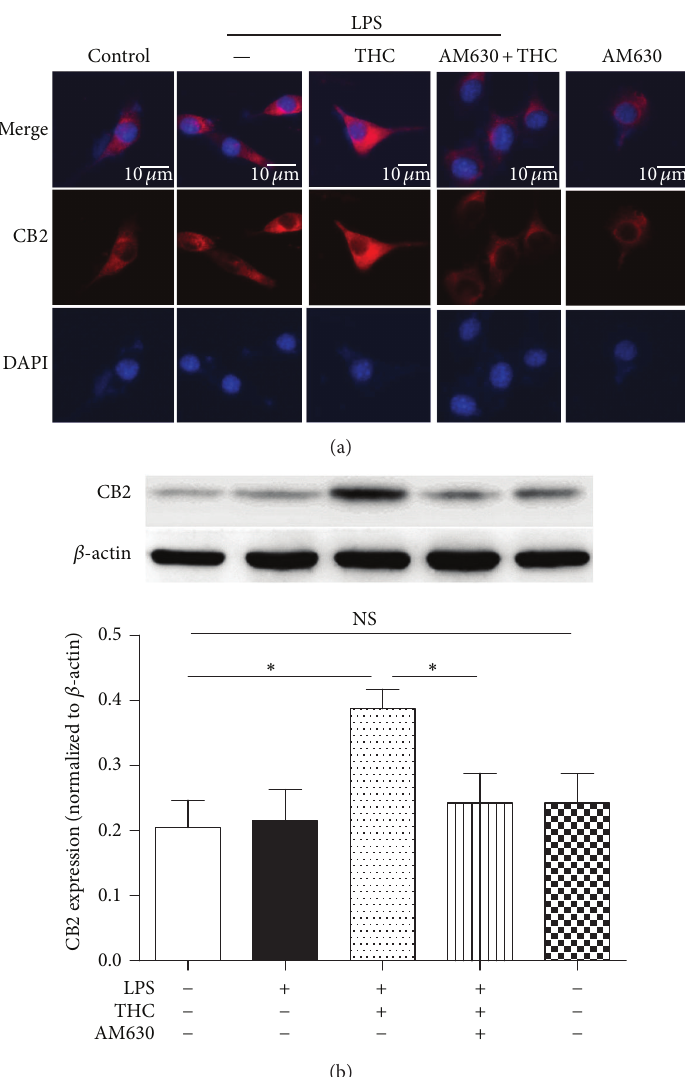
Figure 3: THC upregulated CB2 receptor expression. Immunofluorescent staining (a) and western blot (b) were used to determine the CB2 protein expression. The cells were treated with or without 10 ng/mL LPS for 24 h in the presence or absence of 5 𝜇 M THC or 10 𝜇 M AM630 (CB2 receptor antagonist). The CB2 receptor expression (red) was observed by a confocal microscope, and stronger signal indicated higher expression of CB2 protein. Nuclei were counter-stained with DAPI (blue). Bar = 10 𝜇 m. Results are means ± SD ( 𝑛 = 6 ). ∗ : 𝑃 < 0.05 ; NS: no